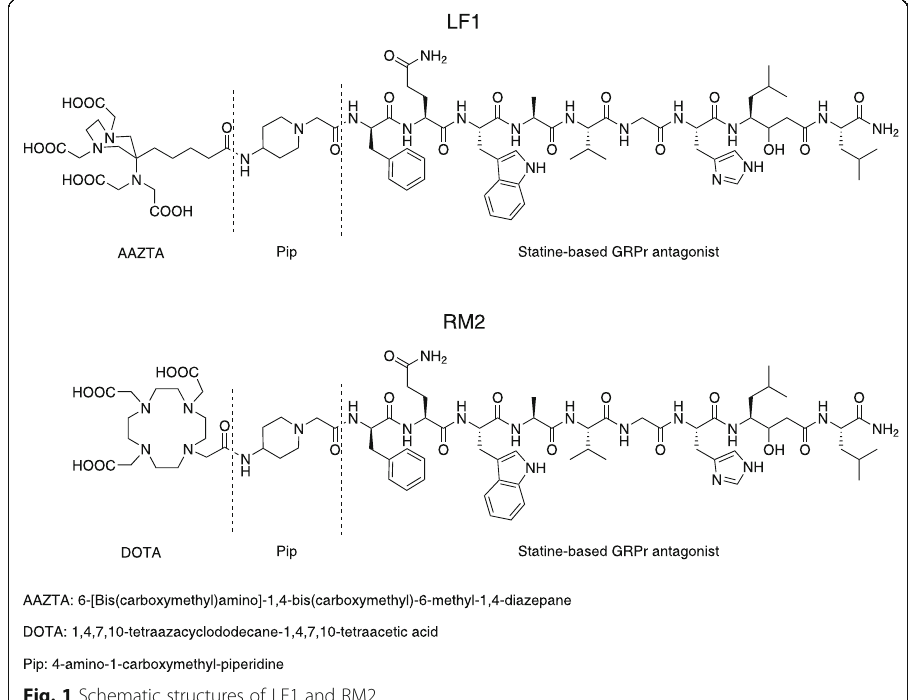
Fig. 1 Schematic structures of LF1 and